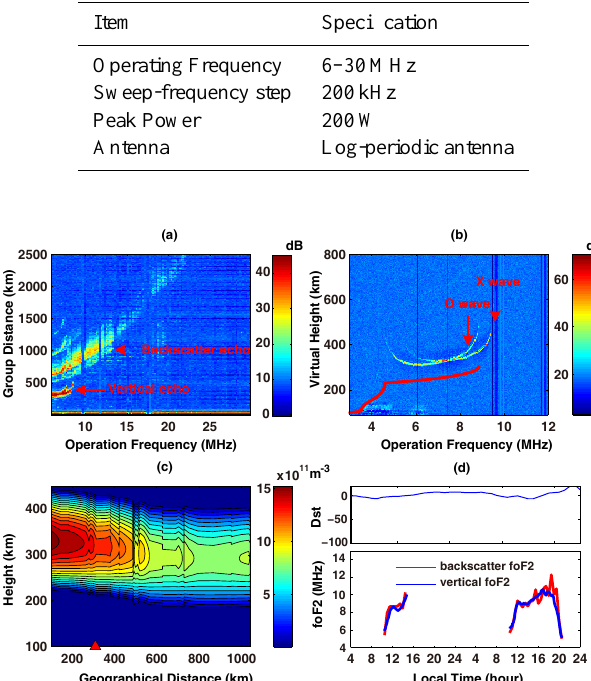
Fig. 3. (a) Backscatter ionogram recorded by the Wuhan WIOBSS at 12:00LT on 26 August 2010. (b) Vertical ionogram recorded by the Yichun ionosonde at 12:00LT on 26 August 2010. The red curve is the electron density profile inverted using POLAN method. (c) 2- D distribution of inverted ionospheric electron density as a function of geographical ground distance and height in the direction of an- tenna main beam. The red triangle indicates the location of the ver- tical ionosonde at Yichun. (d) Comparison of fo F2 obtained from the vertical ionosonde (blue curves) and fo F2 inverted using the backscatter ionogram at a ground distance of 316km (red